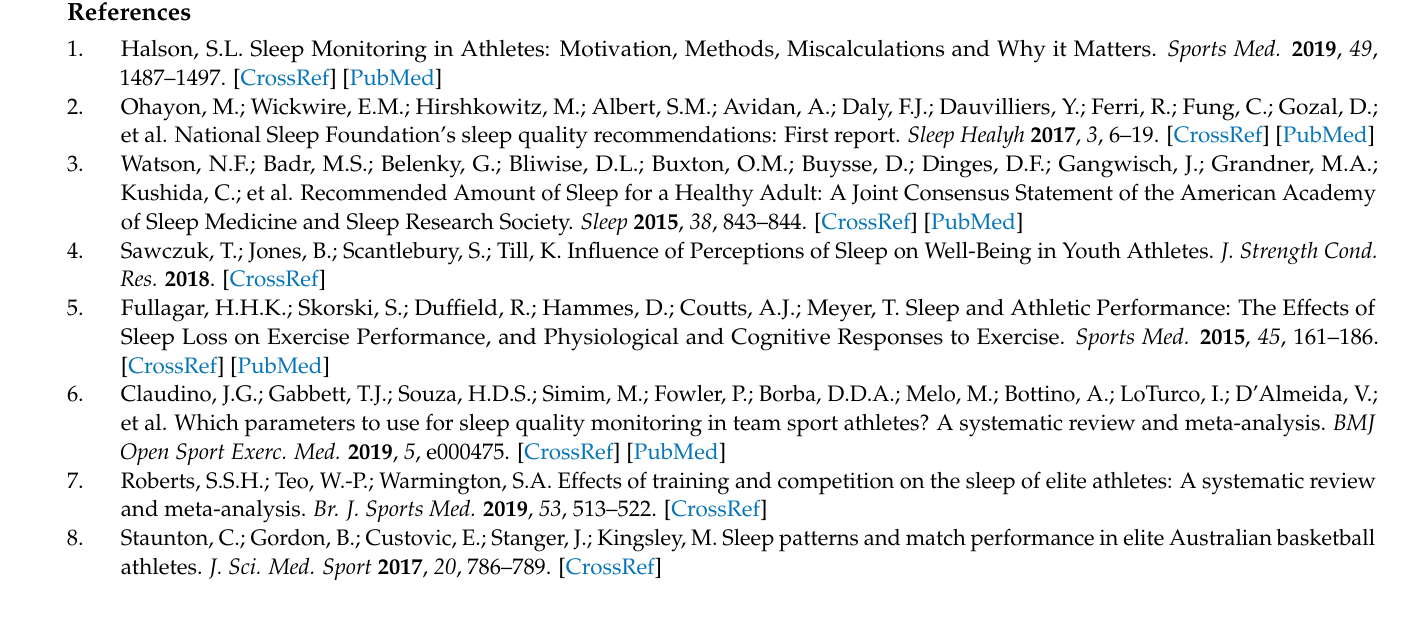
tournament. Figure S2: Individual nocturnal heart rate variability indices data for all players during the 5 days of the